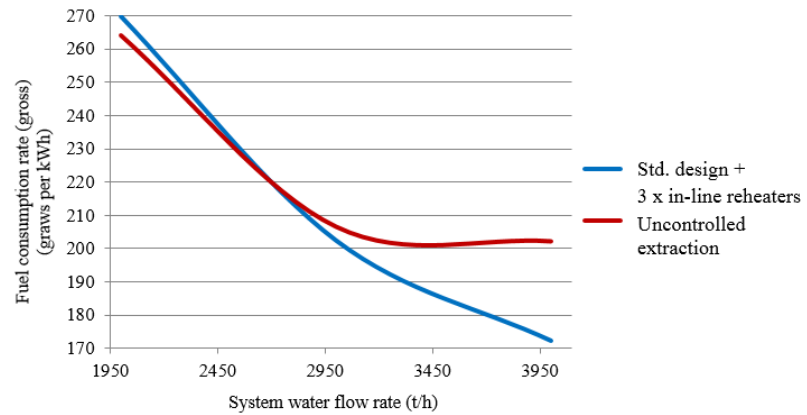
Figure 8. Plots of specific fuel-equivalent flow rates as a function of the system water flow rate for generating unit thermal systems at an outdoor air temperature of 0 °C.